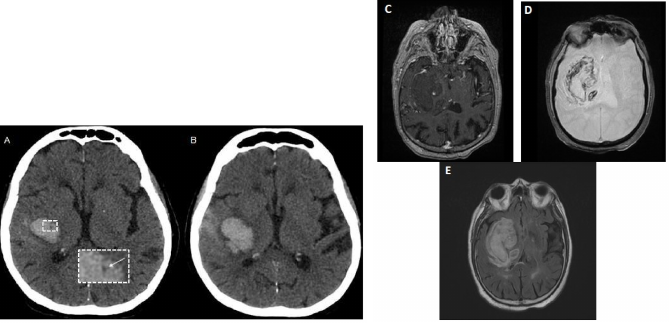
Figure 2. ( A , B ): Example of NCCT markers of ICH expansion. ( A ) Baseline NCCT with evidence of deep ICH and intrahematoma hypodensity (arrow), ( B ) Follow-up NCCT showing hematoma enlargement. ( C – E ) illustrate spot sign on T1-weighted post-contrast magnetic resonance imaging (MRI, C ) within the ICH shown on susceptibility weighted images (SWI, D ) and Fluid Attenuated Inversion Recovery (FLAIR) Sequence ( E